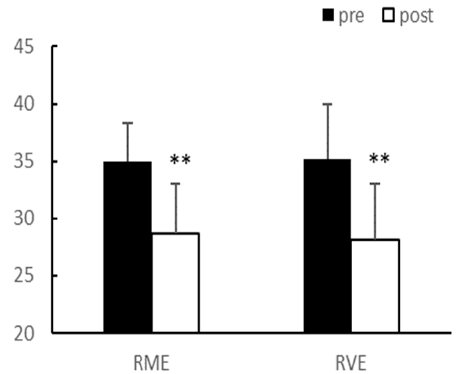
Figure 1. Body weight (kg). Significantly different pre-vs. post-intervention at ** p < 0.01.